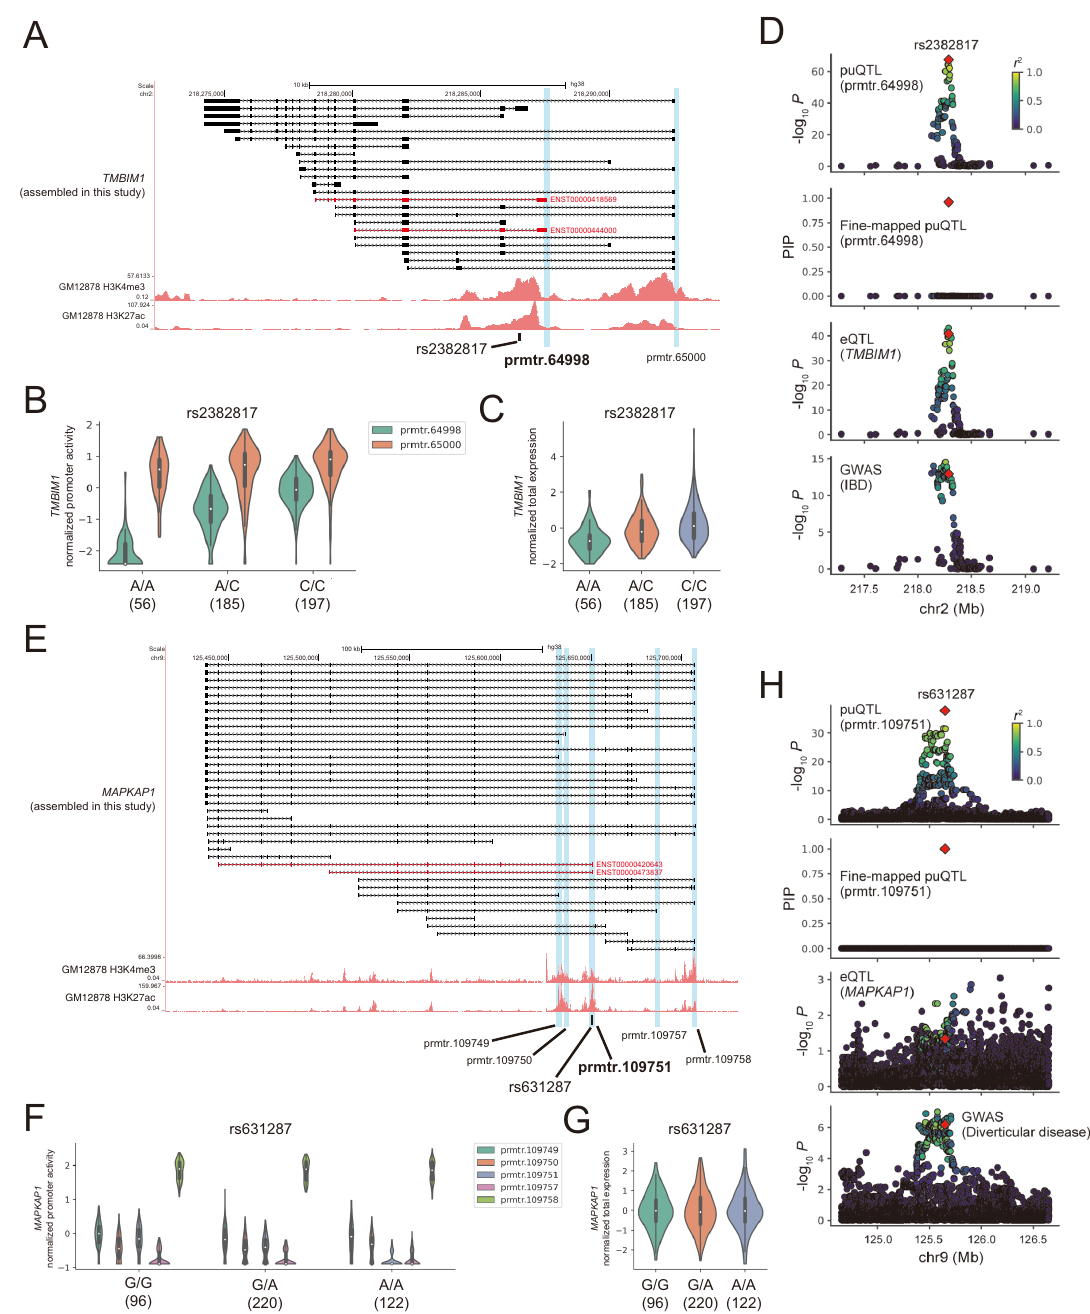
Fig 4. puQTL and GWAS associations. (A) The TMBIM1 gene locus. Structures of the TMBIM1 assembled in this study are presented in black with ENCODE GM12878 H3K4me3 and H3K27ac ChIP-seq signals. The isoforms transcribed from prmtr.64998 are shown in red. The vertical blue bars indicate the location of active promoters. The black bar indicates the location of the rs2382817 variant. (B, C) Comparison of the promoter activities (B) and total expression levels (C) of the TMBIM1 gene among the rs2382817 genotypes. The numbers in parentheses indicate sample size. (D) The associations of puQTL, fine-mapped puQTL for prmtr.64998, eQTL for TMBIM1 , and GWAS of inflammatory bowel disease (IBD) are shown from the top to bottom panels. rs2382817 is plotted in a red diamond, and the colors indicate r -squared values between rs2382817 and other variants. (E) The MAPKAP1 gene locus. The structures of the MAPKAP1 gene assembled in this study are presented in black, and the isoforms transcribed from prmtr.109751 are shown in red. (F, G) Comparison of the promoter activities (F) and total expression levels (G) of the MAPKAP1 gene among the rs631287 genotypes. (H) The associations of puQTL, fine-mapped puQTL for prmtr.109751, eQTL for MAPKAP1 , and GWAS of diverticular disease are shown from the top to bottom panels.